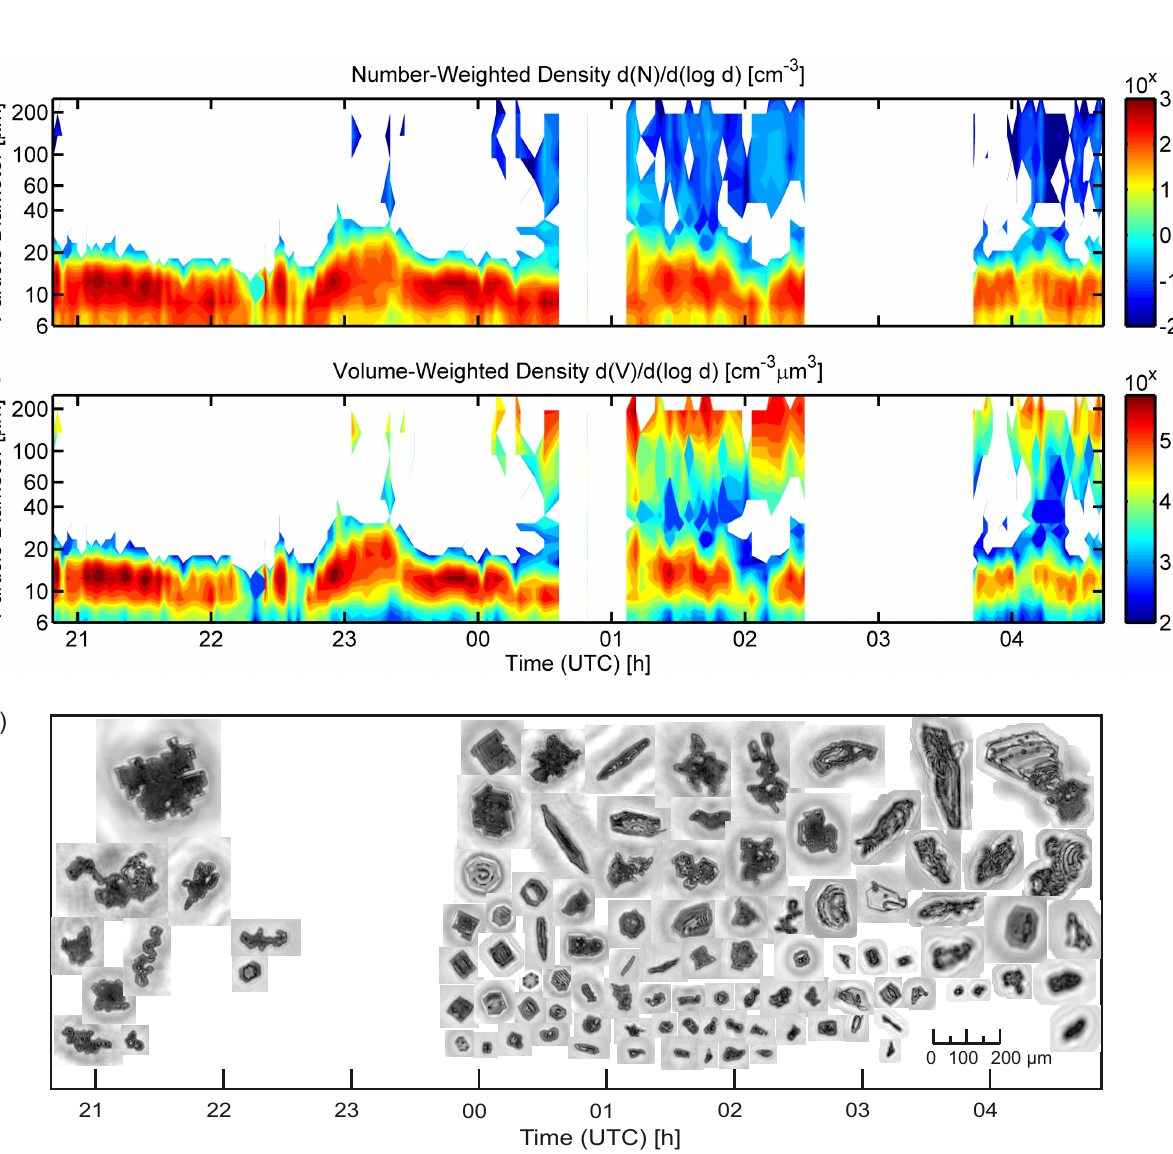
Fig. 9. Time series from the 6–7 April 2012 case measured by HOLIMO II. (a) Cloud particle-number size distribution and (b) volume size distribution. Data gaps are due to icing on the windows. (c) Examples of measured ice